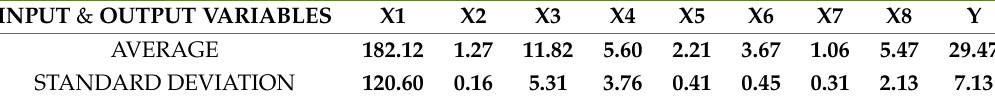
Table 6. Input (X1-X8) variables ‘average and standard deviation for all the 14 lowest output (Y) of UDI c 250 − 750 lx from the school objects.